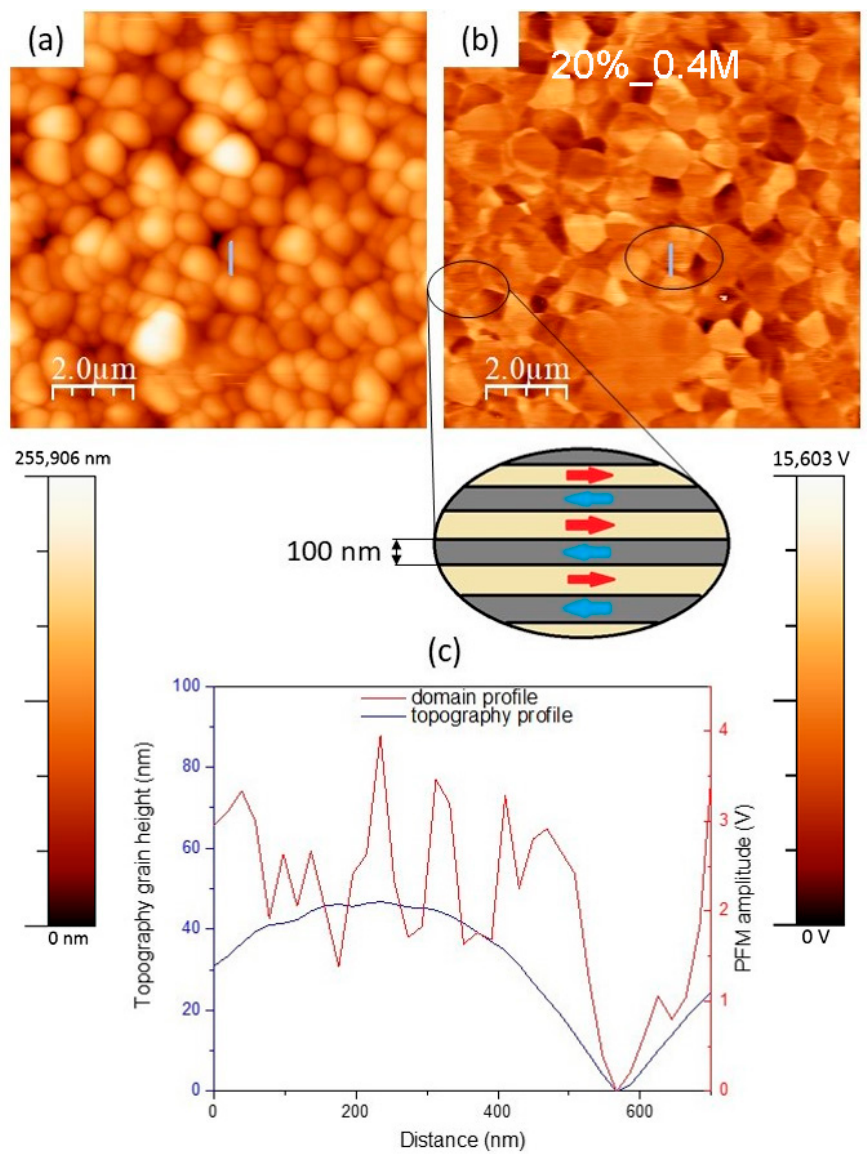
Figure 8. Topography ( a ), out of plane piezo-force response image ( b ), and cross-sections of topography and piezoresponse, taken along the marked line ( c ), for KNN thin films with 20% alkali excess and 0.4 M concentration deposited on platinized Al 2 O 3 . A scheme of the nanodomains observed in the circled arias is also presented.